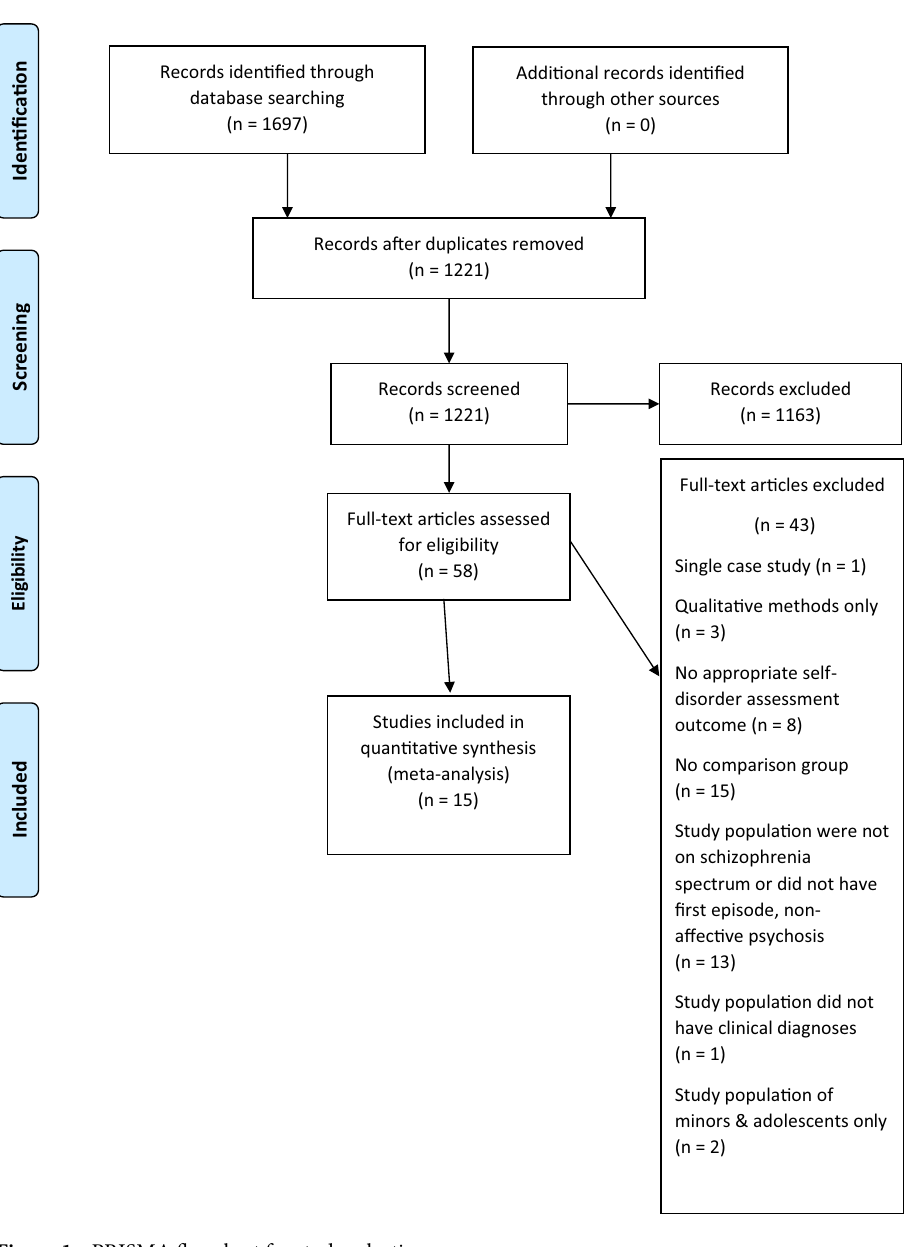
Figure 1. PRISMA flowchart for study